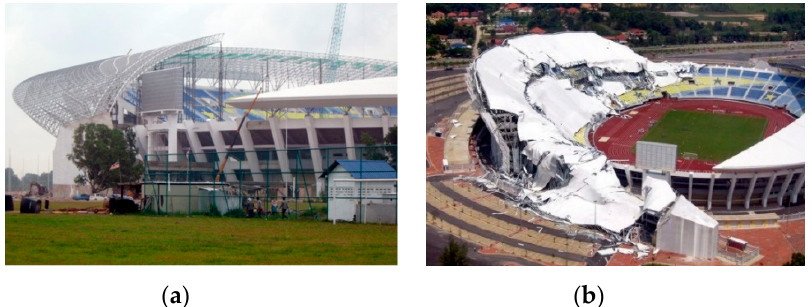
Figure 5. Detail of the collapse of the football stadium roof in Malaysia [52], (a) details of the construction of the Shah Alam Stadium at Malaysia [5], (b) detail of the roof collapse of the Shah Alam Stadium at Malaysia [35,50].